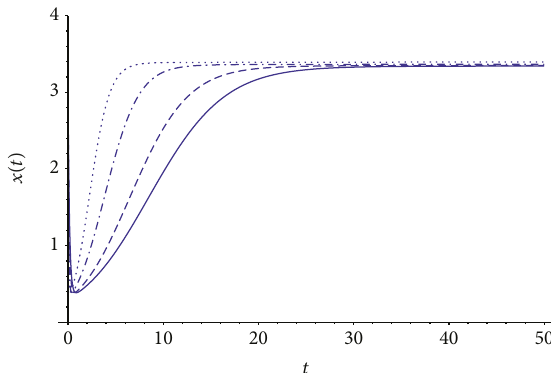
Figure 1: The graph represents the solution behavior for the variable x t versus time t under di ff erent values of the order of derivative. The solid line, dashed line, dot-dashed line, and dotted line represent solution behavior at ζ = 1, ζ = 0 95, ζ = 0 85 , and ζ = 0 75 , respectively.